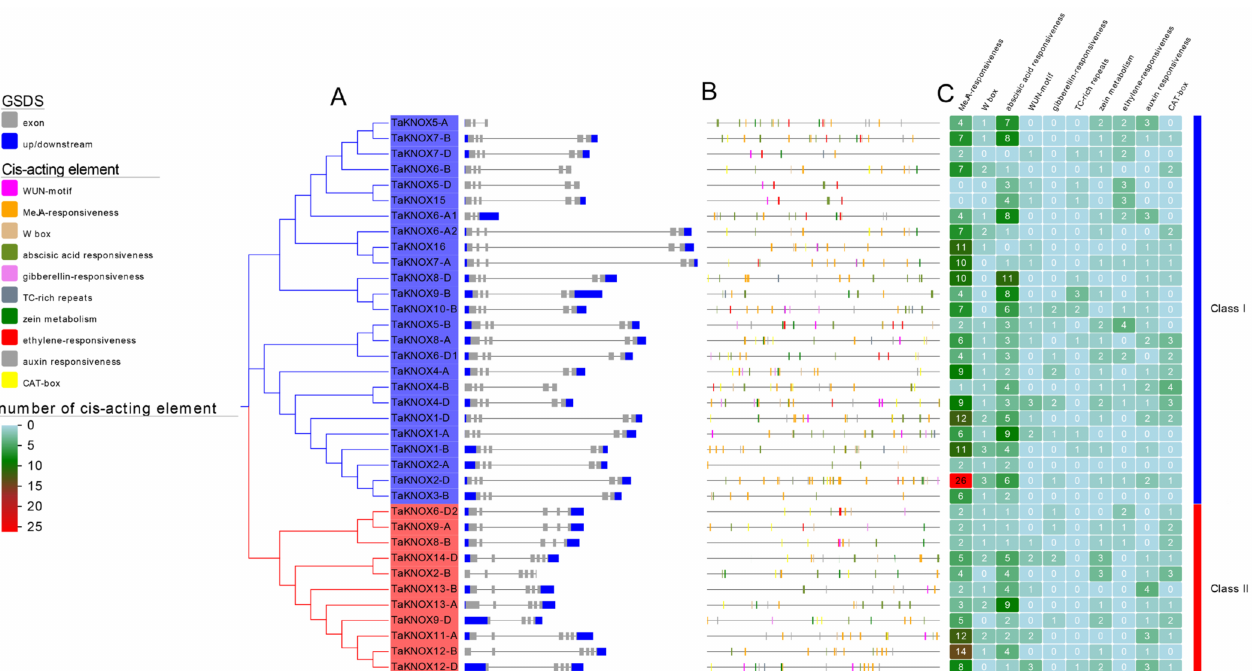
Figure 3. TaKNOX gene structures and cis -acting elements in TaKNOX promoters. ( A ) Phylogenetic tree of 36 TaKNOX genes and gene structures. Blue boxes represent UTRs, gray boxes represent exons and gray lines represent introns. ( B ) cis -acting element locations of TaKNOX gene promoters. The black line represents the promoter length, other different color lines located on the promoter represent the different cis -acting elements. ( C ) Number of cis -acting elements. Bule line and Red line represent the different KNOX